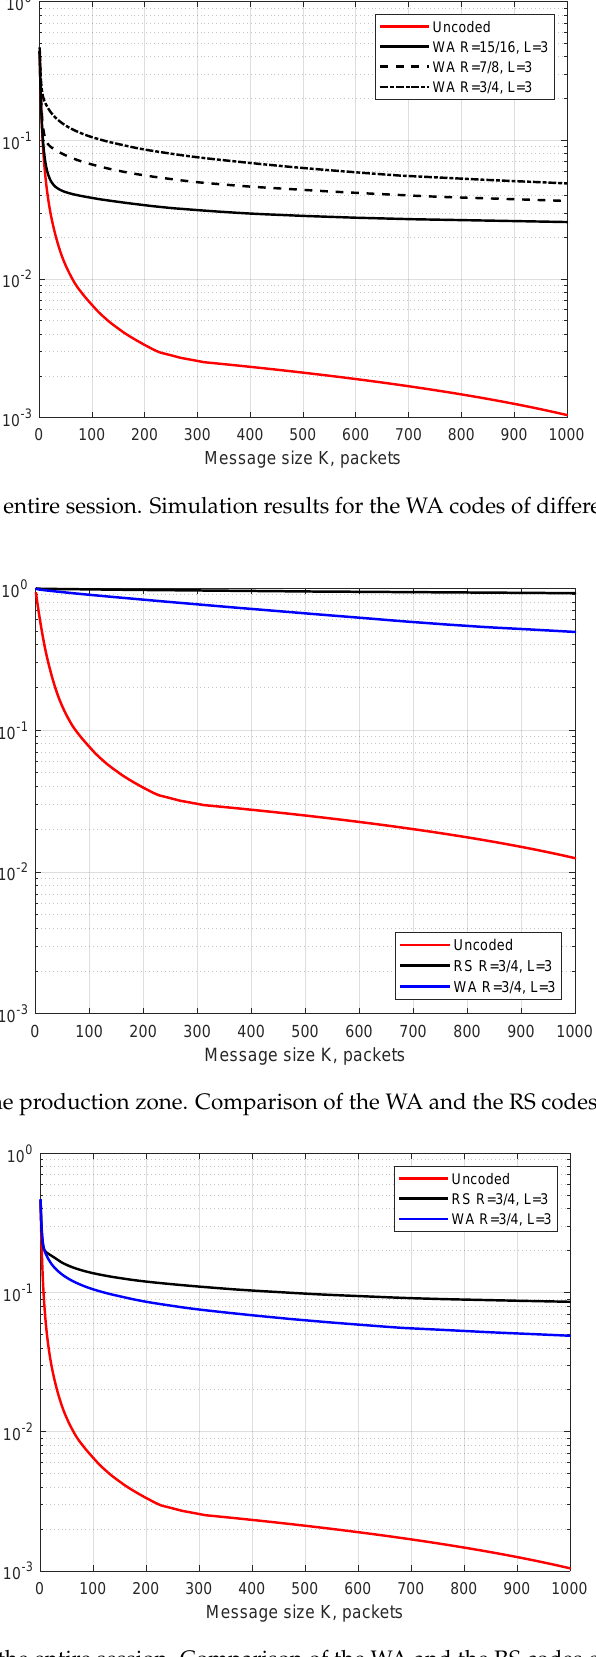
Figure 14. SDF for the entire session. Comparison of the WA and the RS codes of rate R =